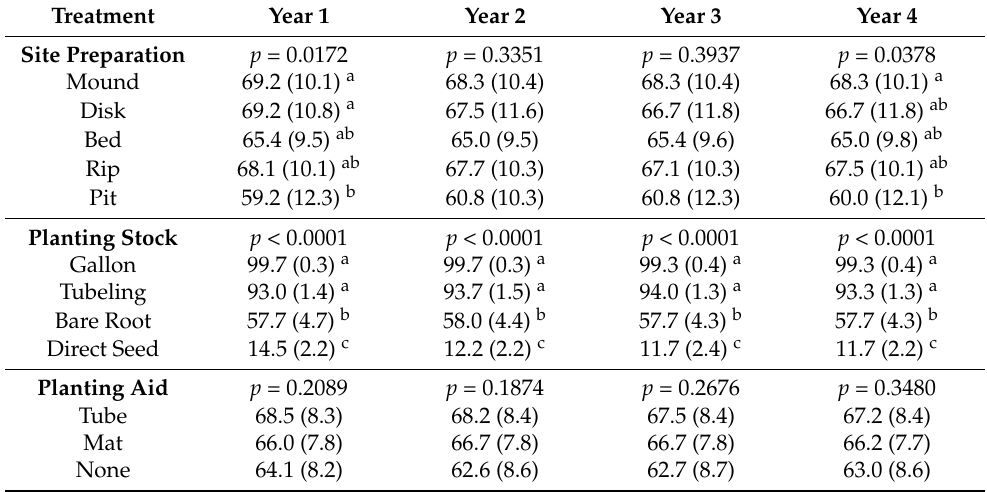
Table 1. Average percent survival (SE) for American sycamore in the Virginia Piedmont by site preparation, planting stock type, and planting aid. Values with different letters indicate statistically significant differences according to Tukey’s post hoc HSD ( p < 0.05). Bolded text indicates treatment